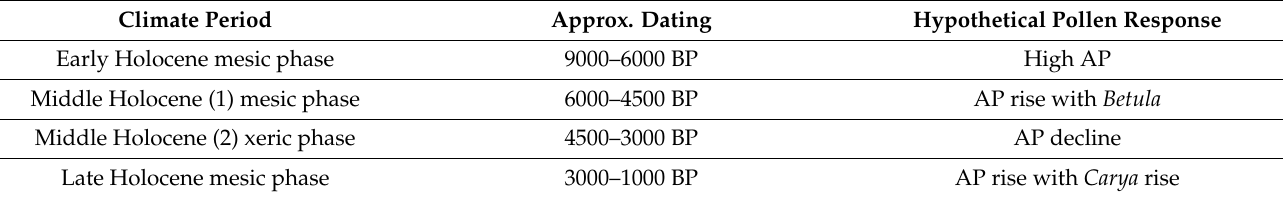
Table 1. Summary climate history model and testing by